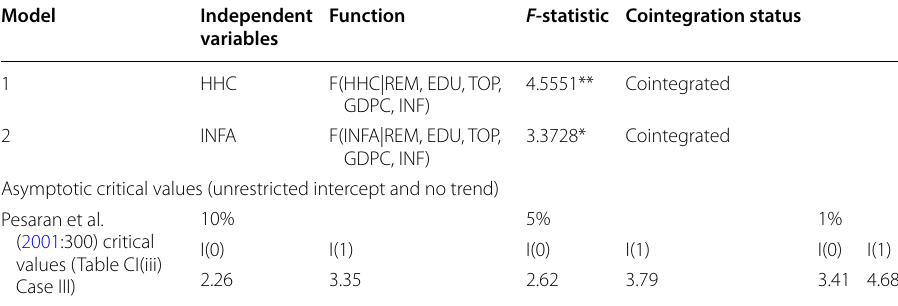
Table 2 ARDL approach to cointegration results Model